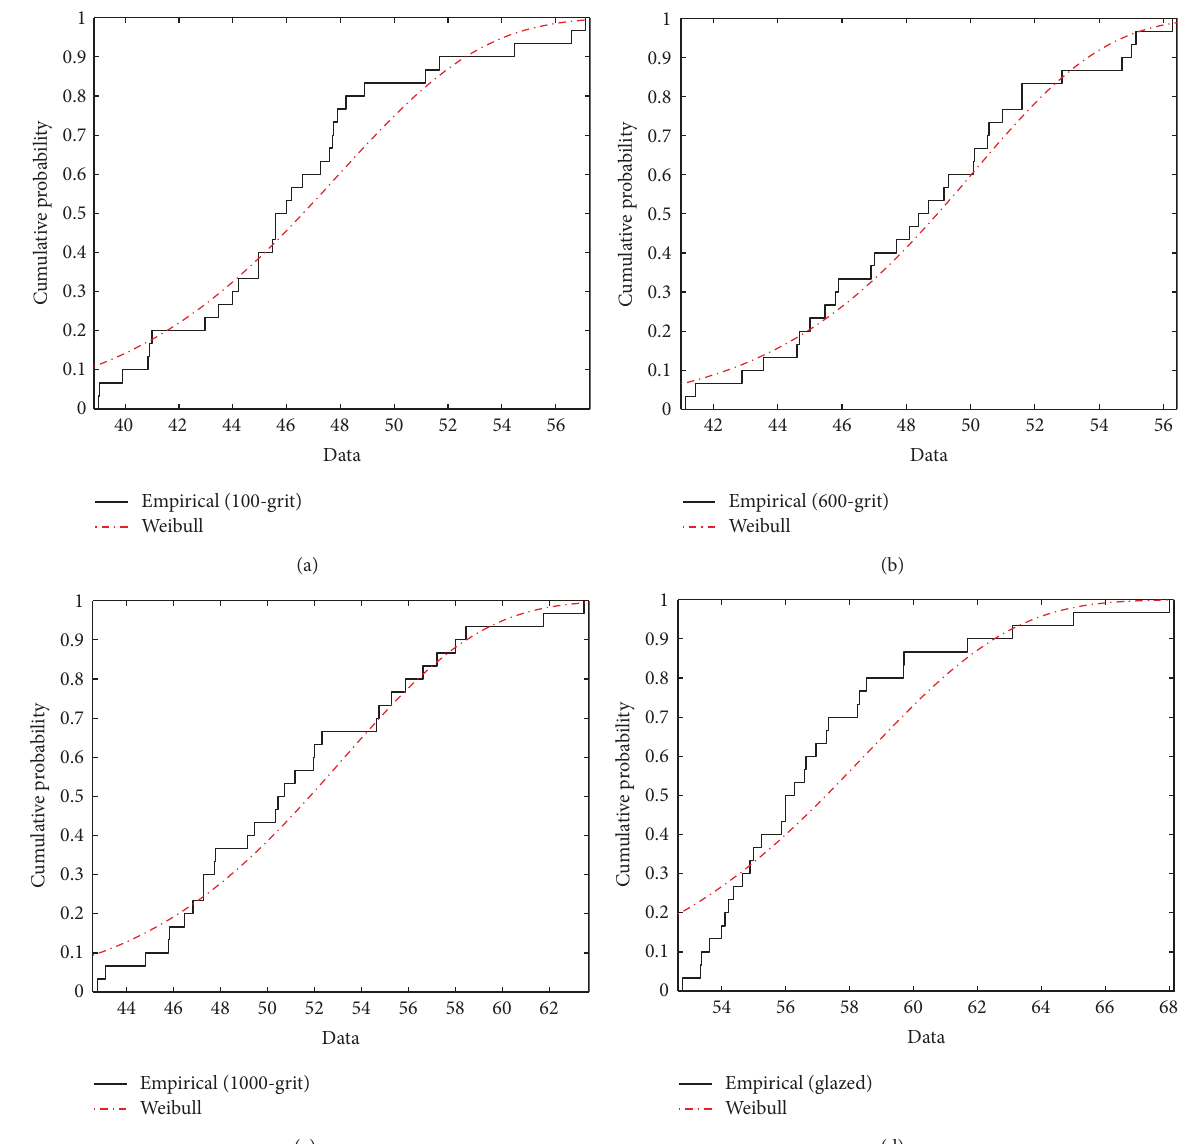
Figure 2: Empirical cumulative distribution function and the fitted Weibull cumulative functions of fracture data of four test